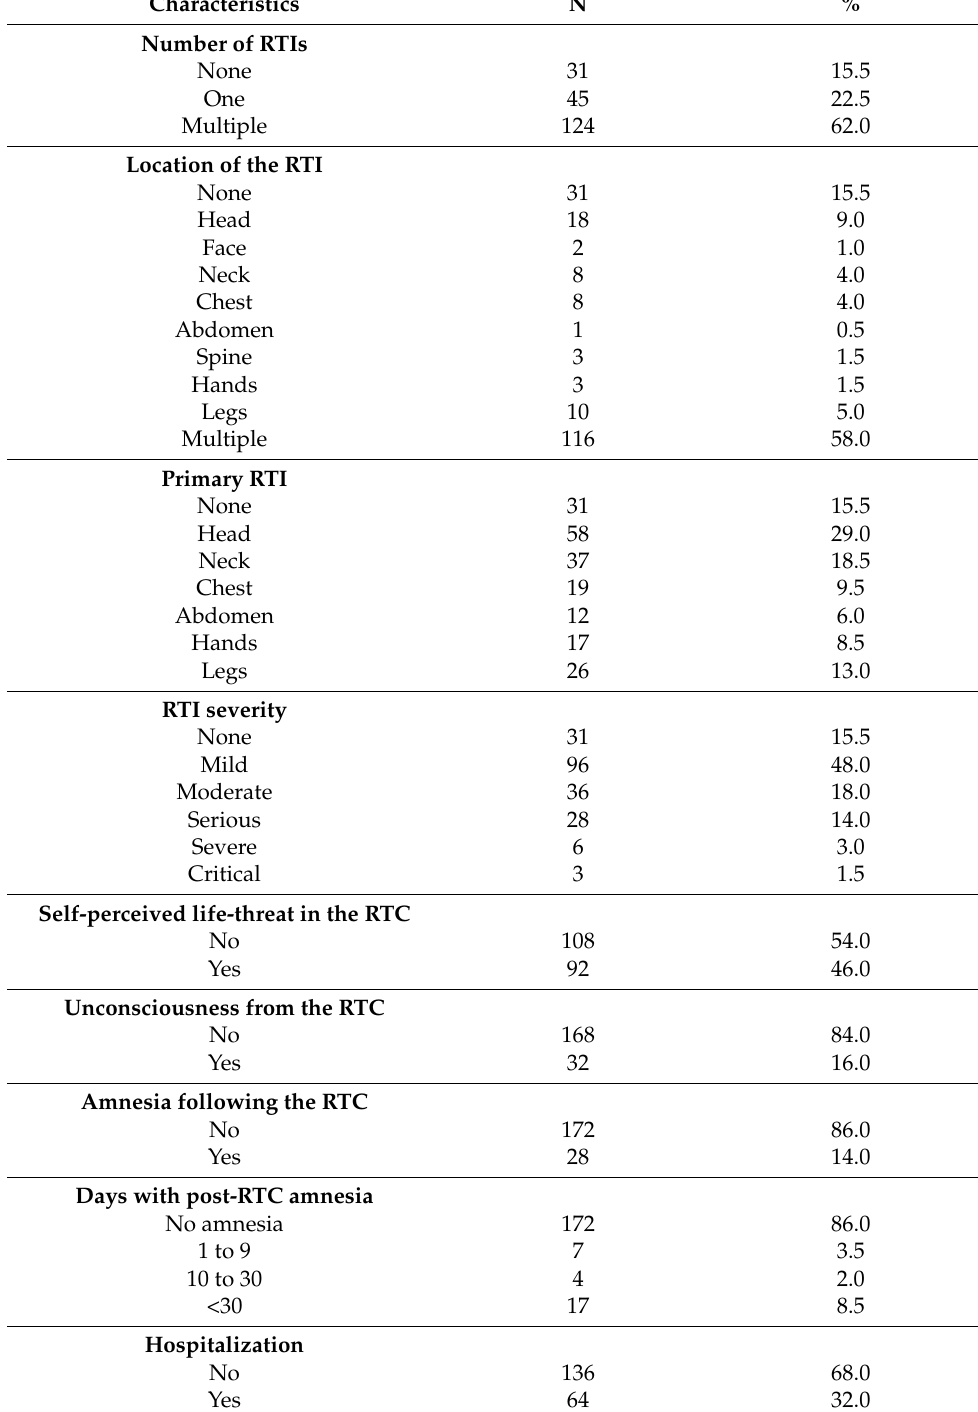
Table 2. Characteristics of the participants 1 month following an